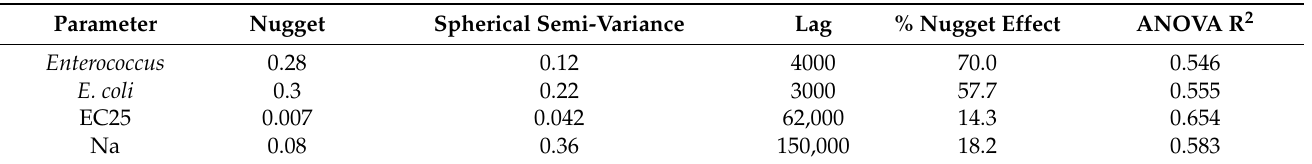
Table 2. Adjusted special variogram parameters and ANOVA R 2 for Enterococcus , E. coli , electrical conductivity 25 ◦ , and